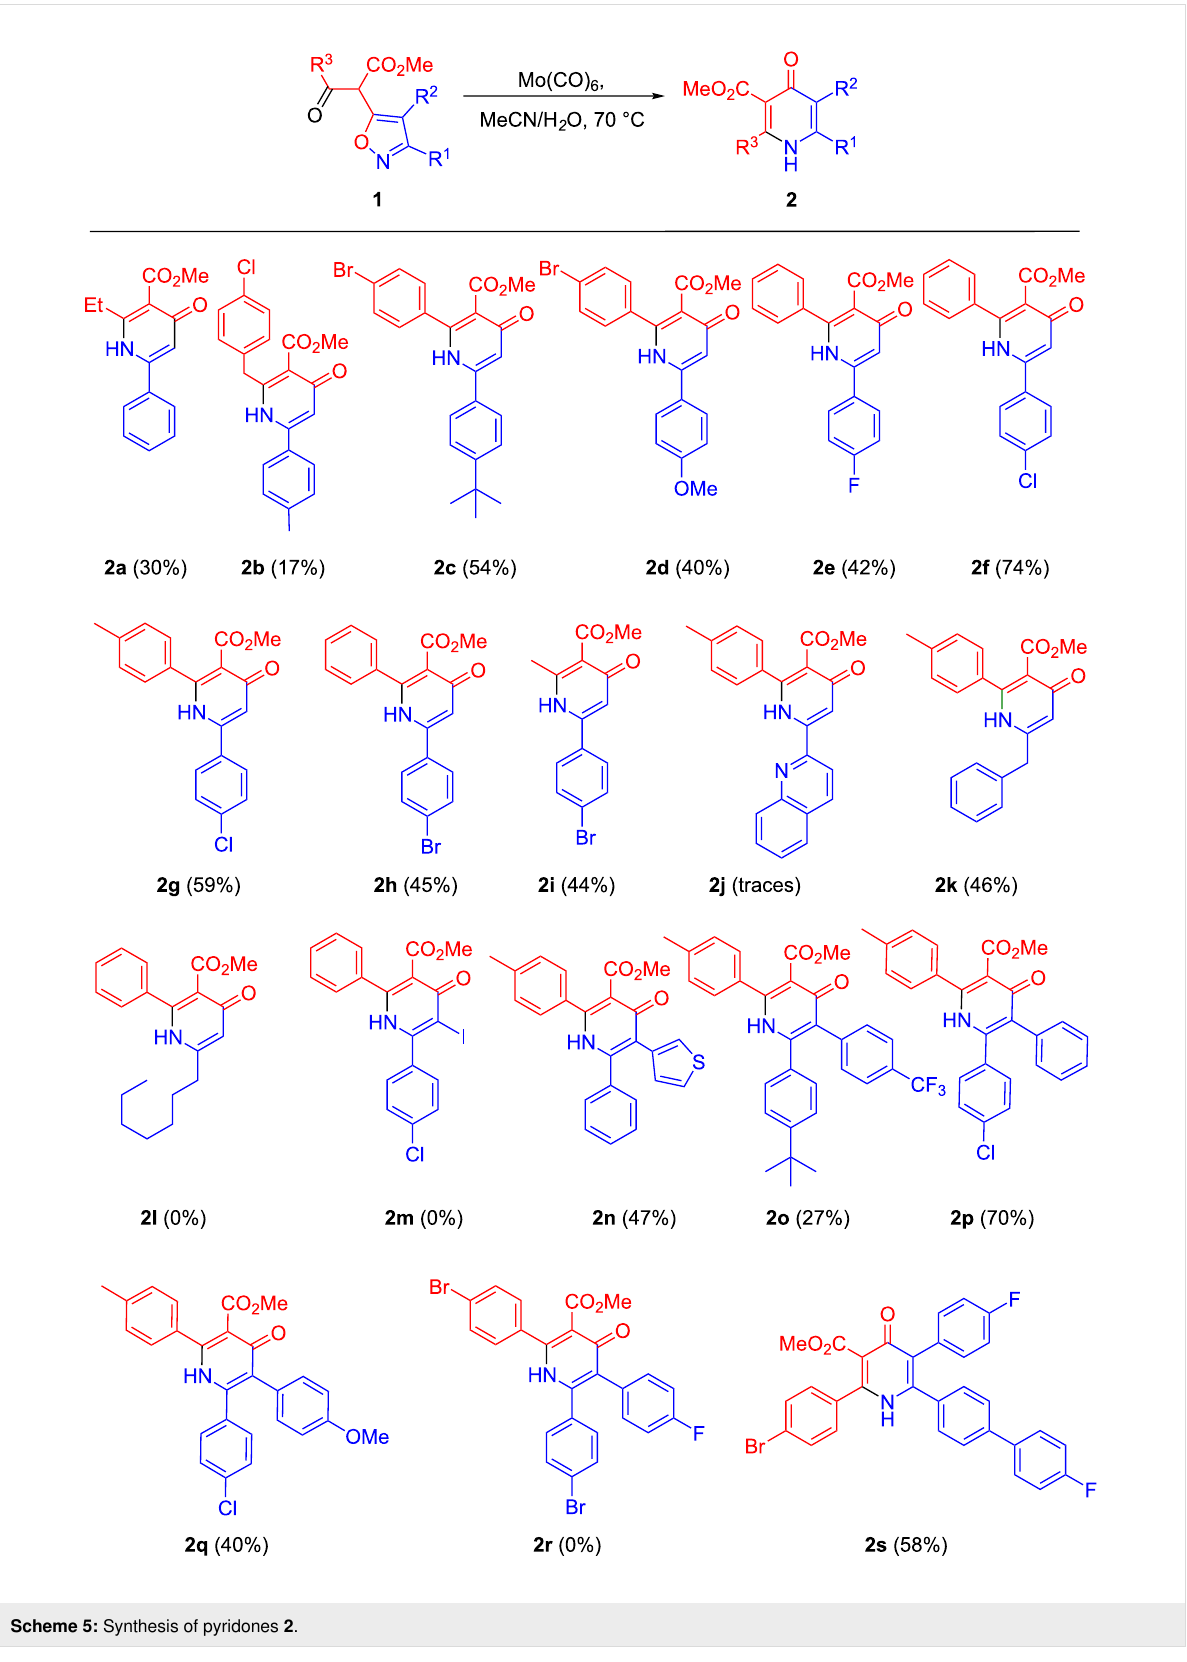
Scheme 5: Synthesis of pyridones 2